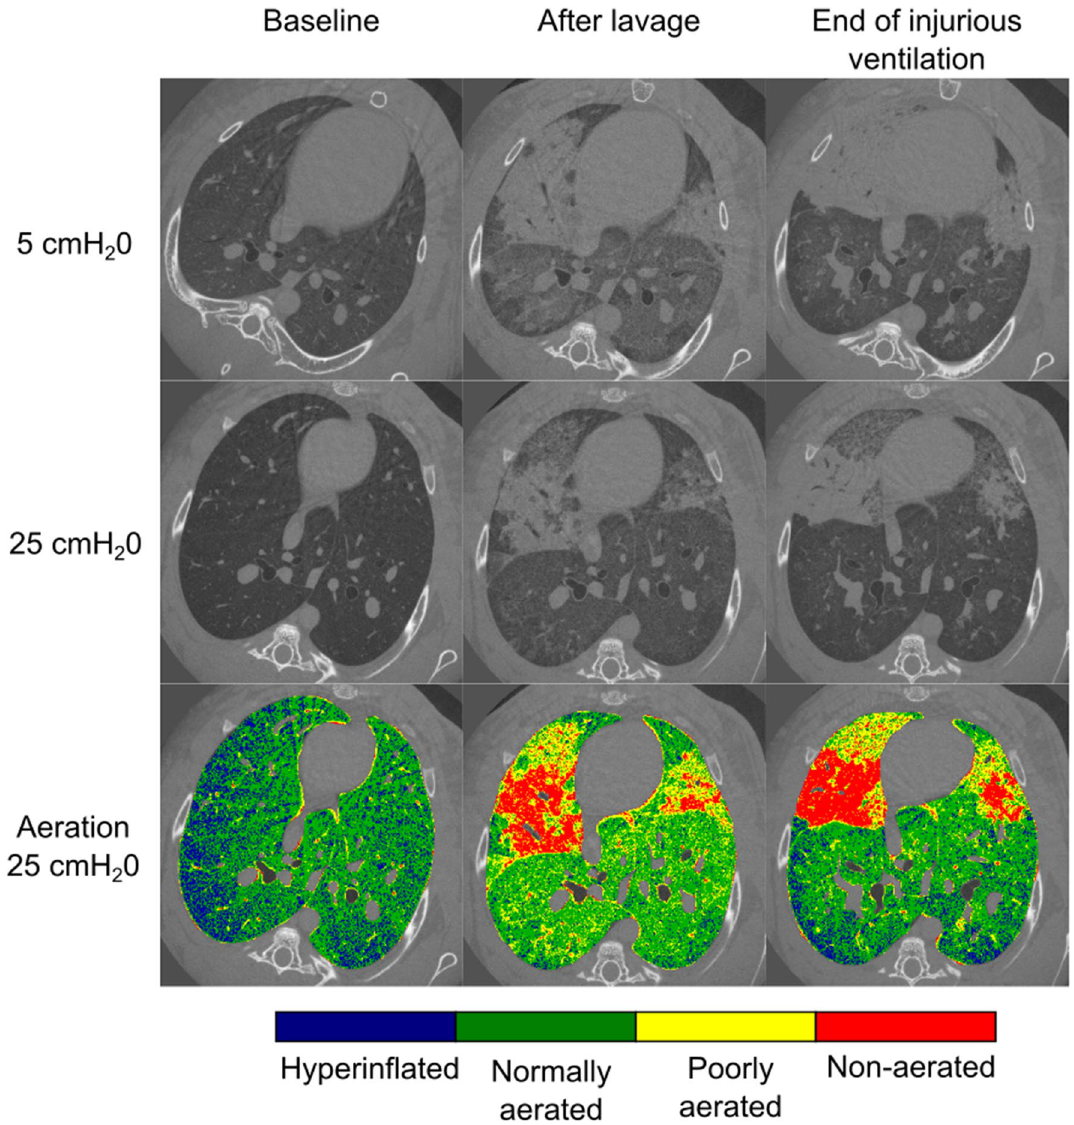
were performed with the animals in upright position. Aeration levels are shown for each time step at 25 cmH 2 O. Non-aerated tissue (red) corresponds to the interval (HU ≥ − 100); poorly aerated tissue (yellow) to (− 500 ≤ HU < − 100); normally aerated tissue (green) to (− 900 ≤ HU < − 500 HU) and hyperinflated tissue (blue) to (HU < − 900 HU). Atelectatic regions develop around lung units which became atelectatic immediately after the